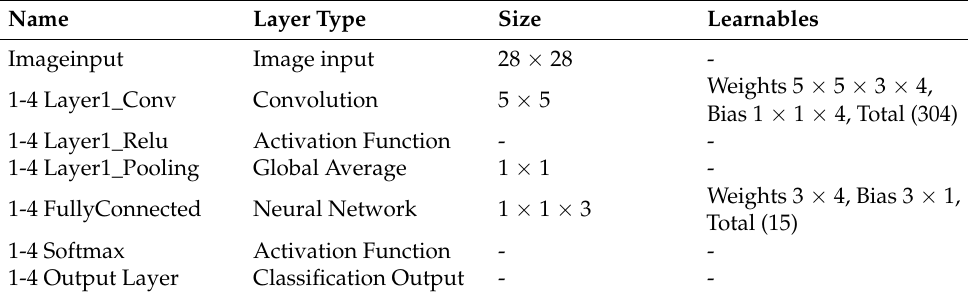
Table 2. CNN Structure and Parameter